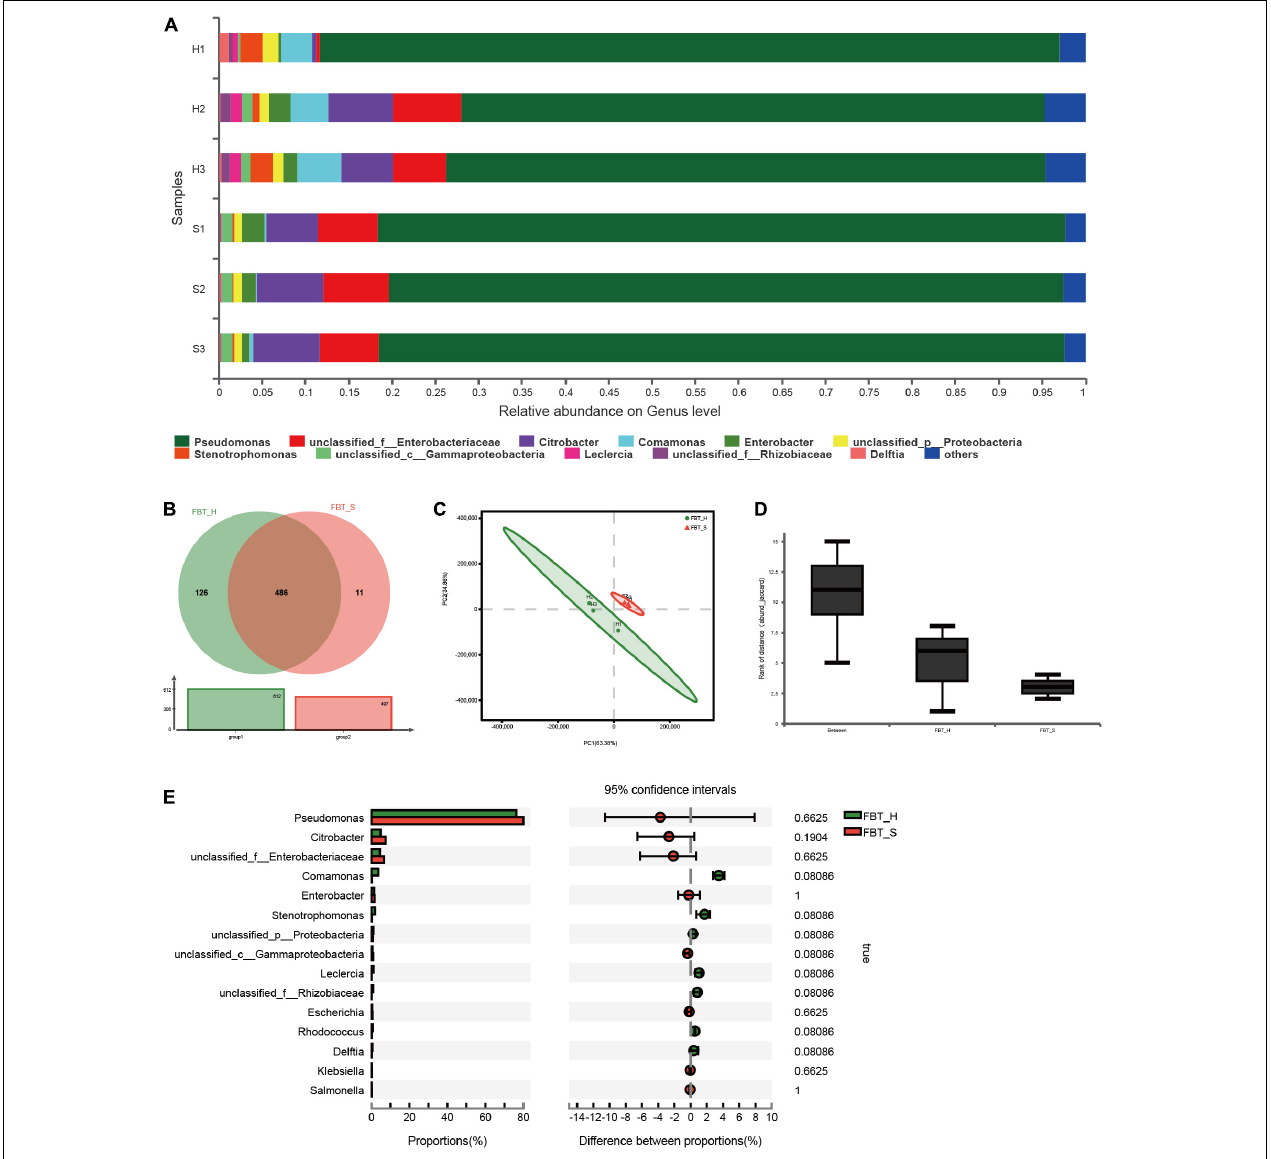
FIGURE 1 | Microbial community composition at the genus level among two FBT groups. (A) The relative abundances of microbial populations. (B) Venn diagram depicting shared taxonomic groups between FBT_H and FBT_S samples. (C) Variation in taxonomic composition among FBT types based on PCA ordination. Different colors indicate different FBT types. The proportion of variation explained by PCA1 and 2 was 63.38 and 34.86%, respectively. FBT_H: H1–H3. FBT_S: S1–S3. (D) ANOSIM analysis of variation based on FBT communities. Inter-group differences are shown by the “Between” box. The “FBT_H and FBT_S” boxes show intra-group differences. (E) STAMP differential analysis of microbial communities between FBT_H and FBT_S samples (error bars indicate Wilcoxon rank-sum